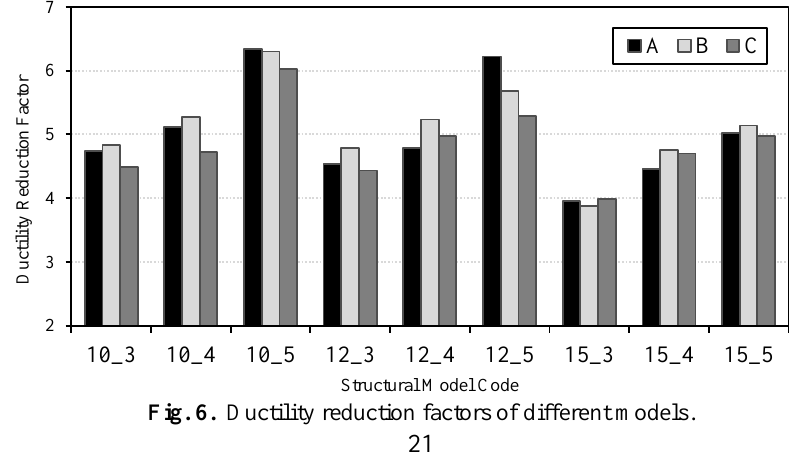
Fig. 6. Ductility reduction factors of different